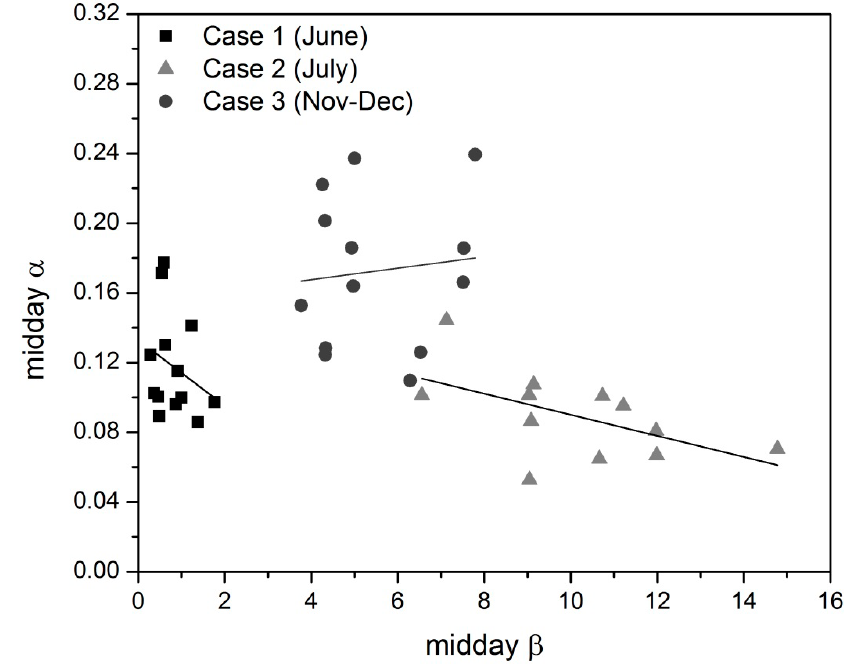
Figure 9. Scatter plots of observed wind shear exponents (α) and observed Bowen ratios (β) for all three cases. Plotted are daily mean midday values. This plot shows a similar correlation between wind shear and surface energy exchange during the summer months. In Cases 1 and 2 higher β (sensible heat > latent heat) was correlated with less wind shear (lower α). This relationship is not seen during the cool, d ry Case 3 period which indicates a weaker surface-atmosphere forcing in